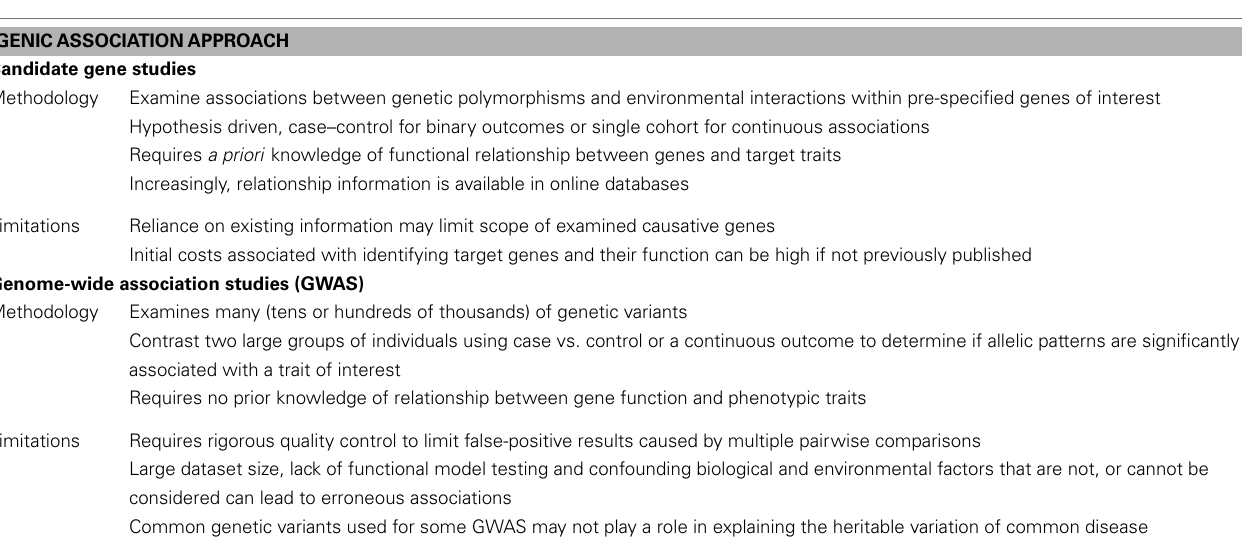
Table 1 |A comparison of two major methods used to conduct gene association studies, candidate gene studies, and genome-wide association studies